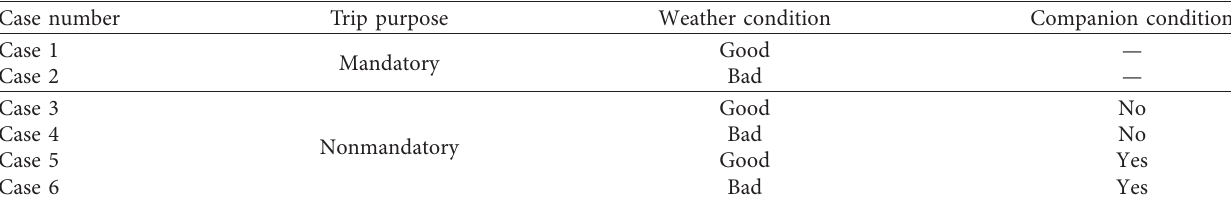
Table 4: List of selected cases for mode choice models.